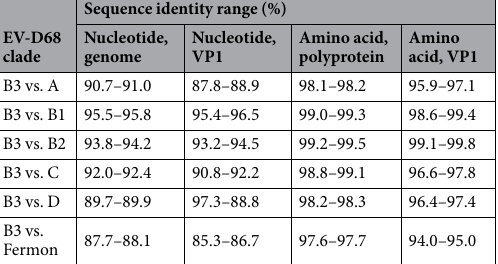
Table 3. Nucleotide and amino acid sequence identity between subclade B3 and other subtypes of EV-D68 strains a . a Based on comparisons of 50 complete genomes of subclade B3 strains and representative strains from other clades and subclades of enterovirus D68. See Fig. 3 for a list of strains included.